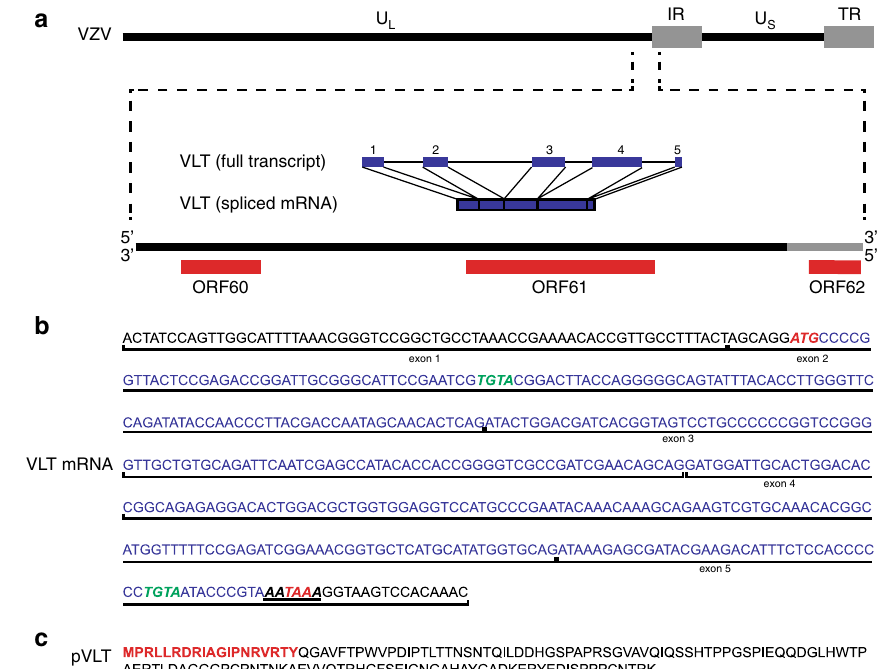
Fig. 3 The genomic locus encoding the VZV latency-associated transcript (VLT). a Schematic diagram showing the location and structure of the fi ve VLT exons (blue blocks) and introns (blue lines) within the genomic region 101,000 – 106,000 (coordinates refer to VZV reference strain Dumas; NC_001348.1) (Supplementary Table 3). b The VLT mRNA sequence including the 5 ’ untranslated region; start and stop codons are highlighted in red italic, while the cleavage factor I (CFI)-binding motifs are highlighted in green italic and the canonical polyadenylation signal site (AATAAA) is underlined. Location and boundaries of VLT exons are indicated by vertical black lines. c The fully translated VLT protein (pVLT), with the sequence of peptide (red) used to produce rabbit polyclonal anti-pVLT